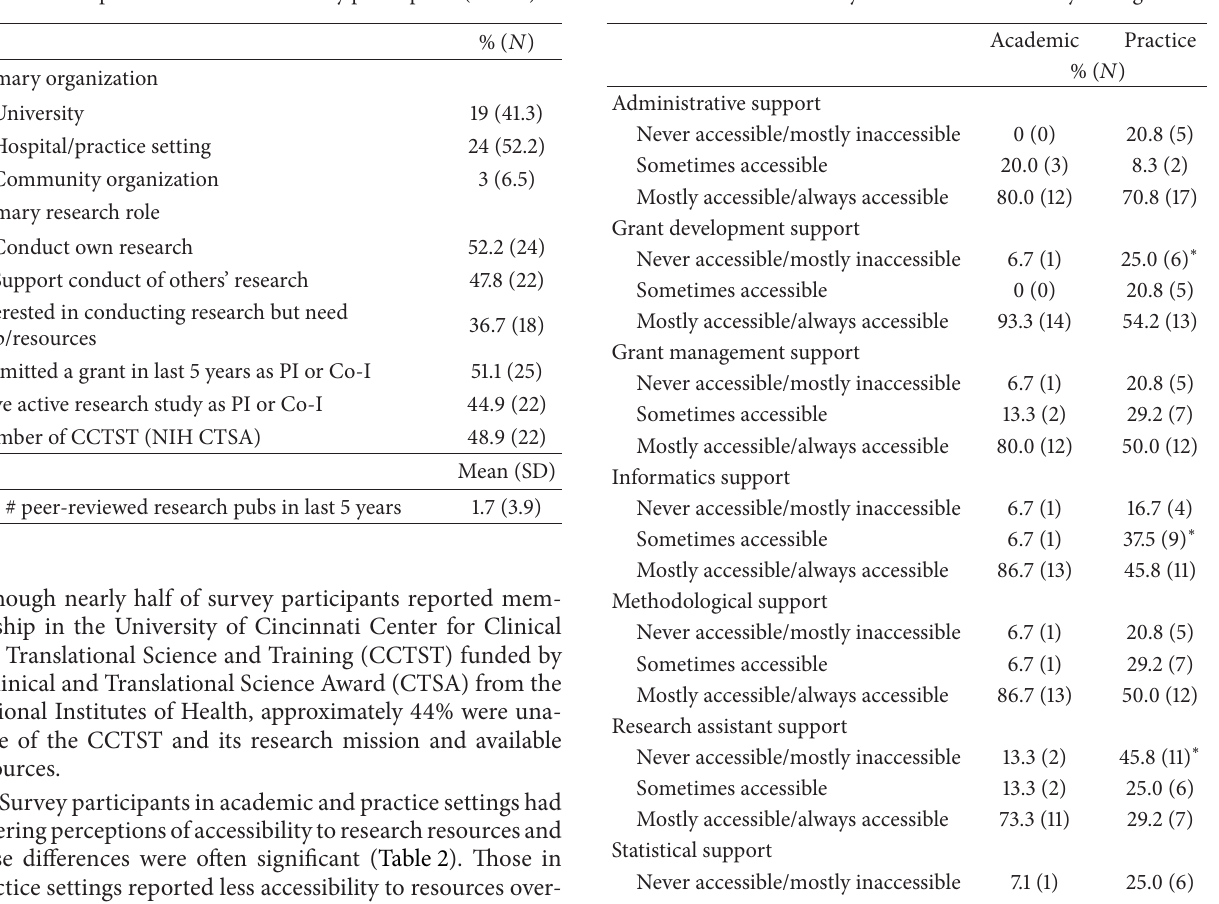
Table 1: Sample characteristics of survey participants (𝑛 = 49) . Table 2: Accessibility of research resources by